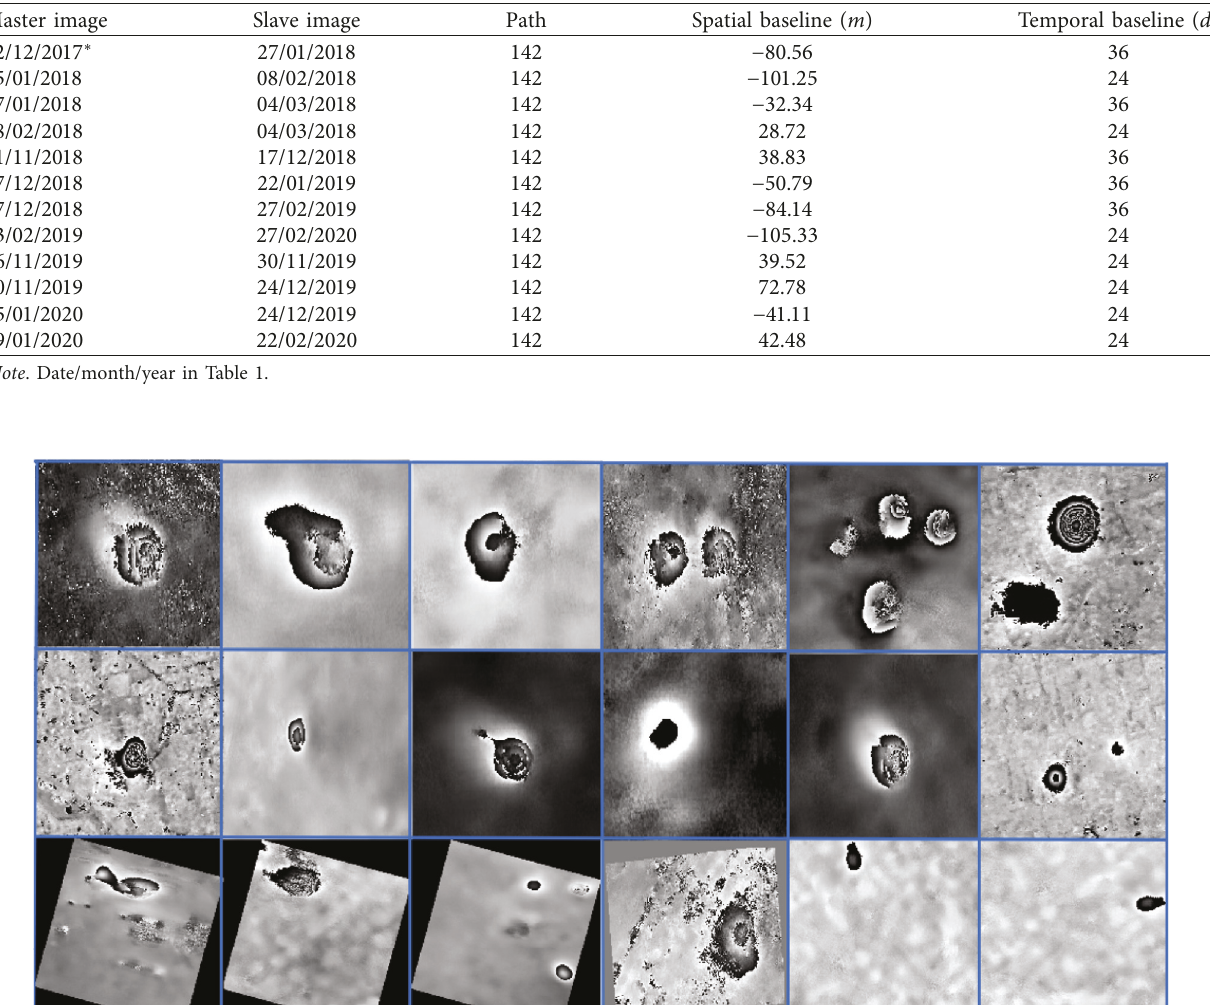
Table 2: Parameters of interferograms for making sample datasets.